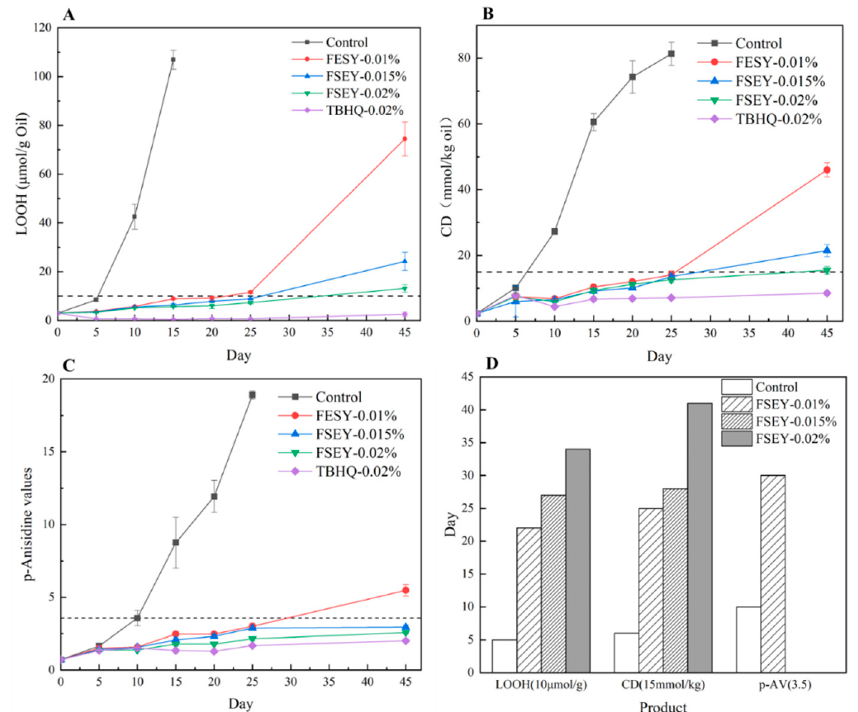
Figure 2. ( A – C ) Changes in primary (LOOH and CD) and secondary ( p -Av) lipid oxidation product values stored at 37 °C for 25 days. Values are expressed as mean ± SD ( n = 3). ( D ) The replot of Figure 2A–C showing the effect of FSEY at different levels on time required to increase the LOOH, CD, and p ‐ AV contents to 10 μ g/mL, 15 mmol/kg, and 3.5, respectively.